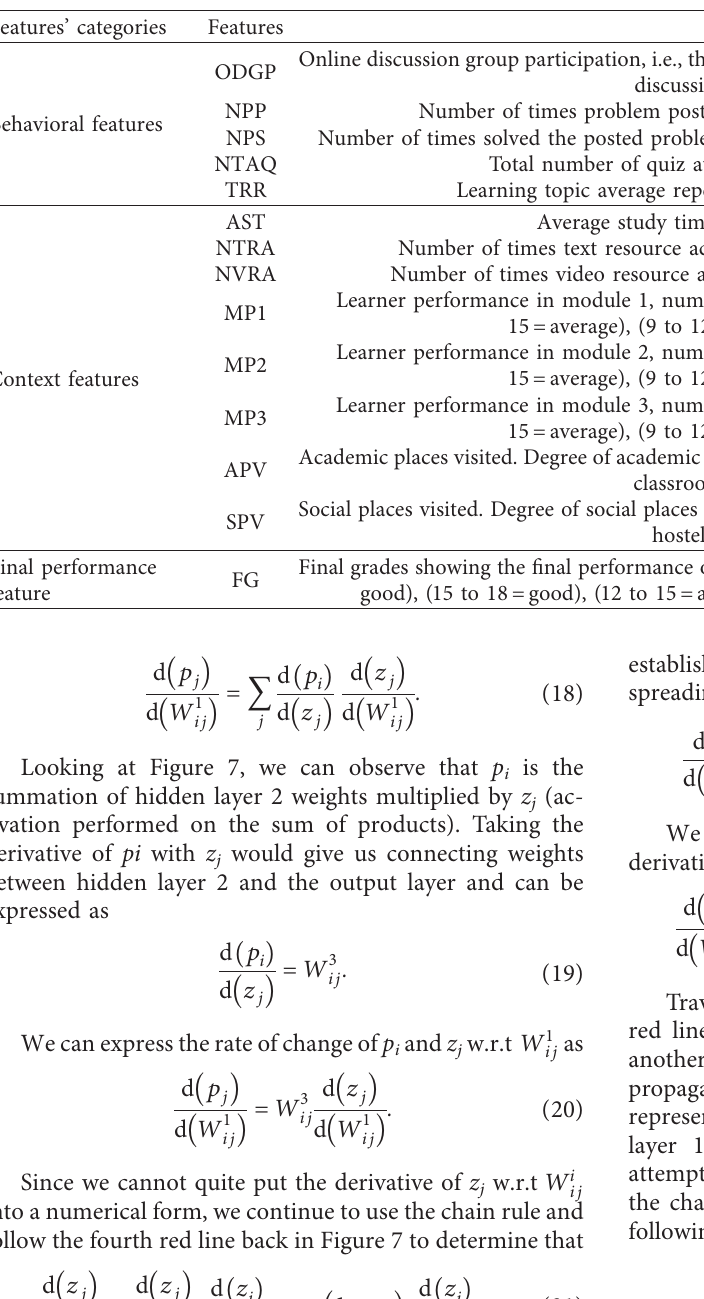
Table 2: Preprocessed features along with their category and